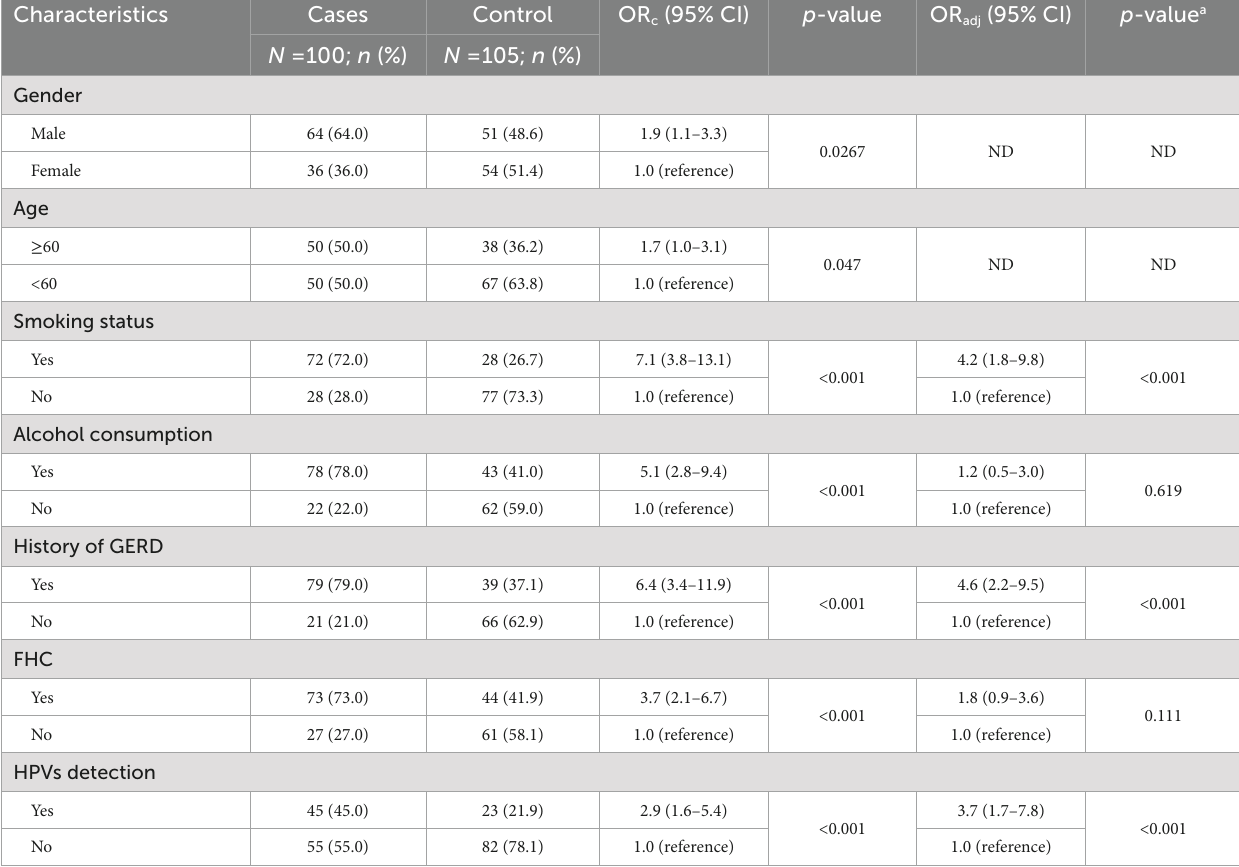
TABLE 3 The association between various clinicopathologic risk factors and ECs.